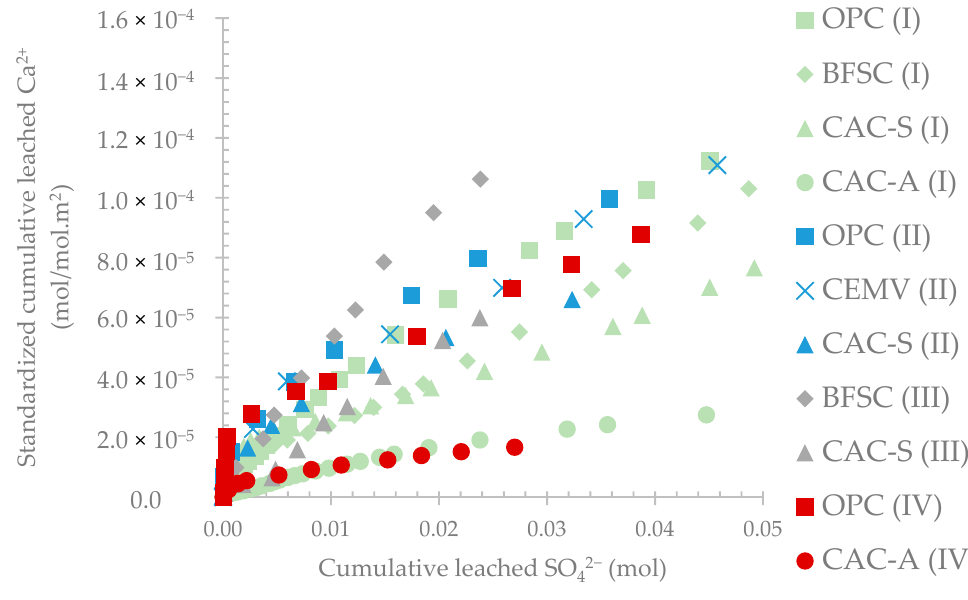
Figure 9. Evolution of the standardized cumulative leached calcium per square meter in function of the cumulative leached sulfate in the leached solution.